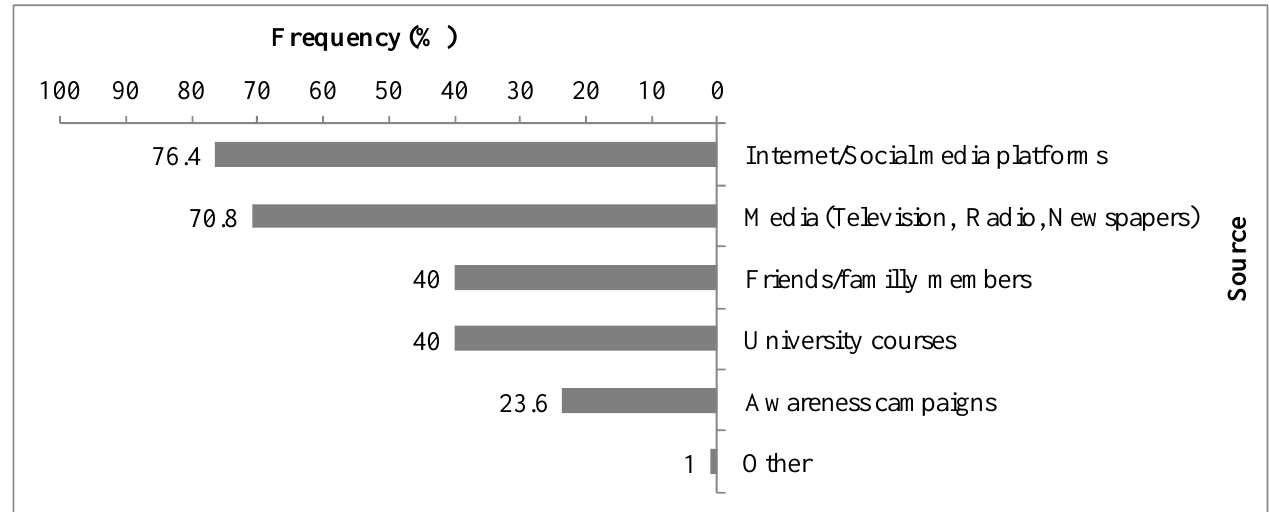
Figure 1. Sources of information about CC of the students asked.